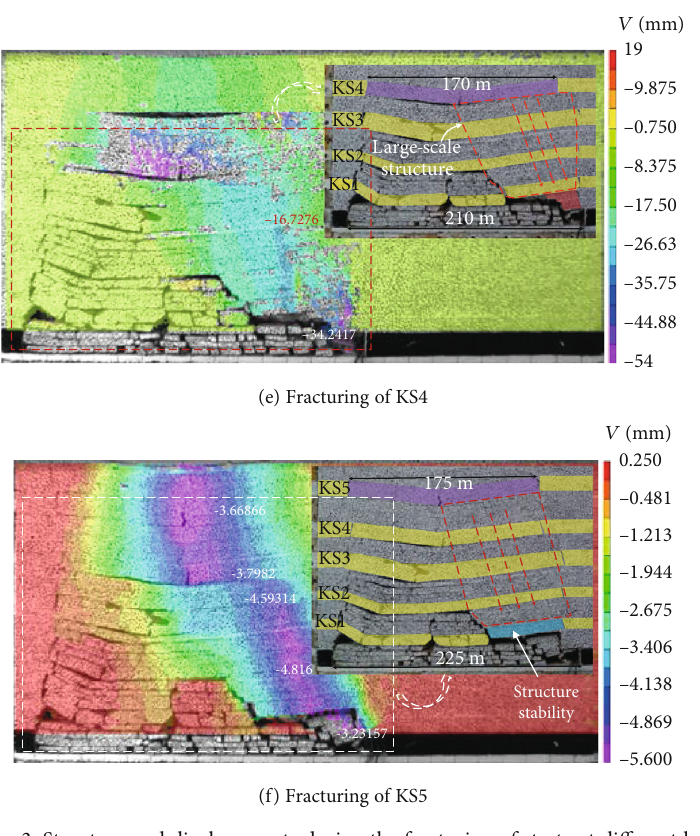
Figure 3: Structure and displacements during the fracturing of strata at di ff erent levels. Table 4: The calculated elasticity modulus of strain gauges. No.